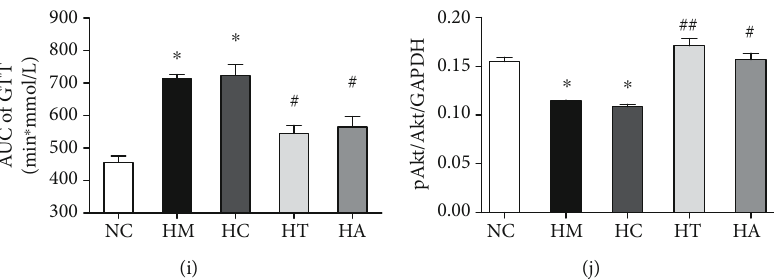
Figure 2: TLR4/AP-1 siRNA transfection ameliorated high-fat diet-induced obesity and insulin resistance in mice. No signi fi cant di ff erence was observed in energy intake between NC, HM, HC, HT, and HA (a). Body weight, the weight of epididymal fat (eWAT), and wet weight of the liver were signi fi cantly increased in HM and HC compared with NC, and these changes were reversed in HT and HA (b – d). The glucose tolerance (GTT) and systemic (fasting plasma insulin level and ITT) and hepatic (Akt phosphorylation in the liver) insulin sensitivity were signi fi cantly impaired in HM and HC, and these changes were relieved in HT and HA (e – j). ∗ p < 0 : 05 and ∗∗ p < 0 : 01 compared with the NC group; # p < 0 : 05 and ## p < 0 : 01 compared with the HM